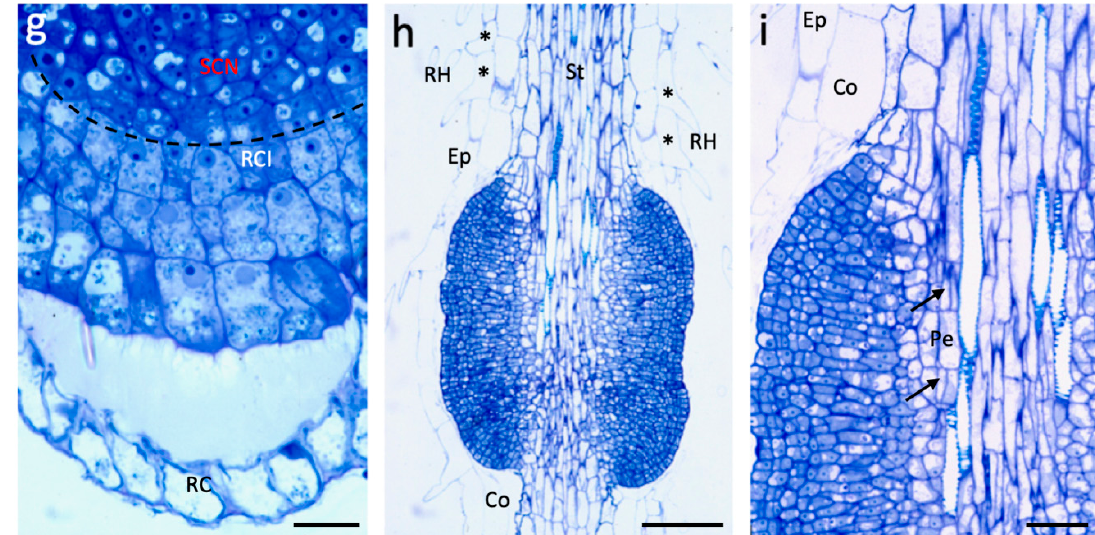
Figure 4. AtAGL12 overexpression in Arabidopsis thaliana . ( a ) Sense (S) T 1 kan R plantlets 10 days after germination; scale bar: 1 cm; ( b ) wild-type (WT) plantlets 10 days after germination; scale bar: 1 cm ( c ) Antisense (AS) T 1 kan R plantlets 10 days after germination; scale bar: 1 cm; for each plantlet, an arrow points to the apical root tip. ( d ) Schematic longitudinal section of a WT Arabidopsis root tip adapted from [28]. The main cell types forming the root apical meristem are indicated in di ff erent colors: RC: root cap (grey-blue); Ep: epidermis (dark blue); Co: cortex (light blue); E: endodermis (purple-grey), Pe: pericycle (purple); St: Stele (orange). In the stem cell niche (SCN, encircled in red) of the meristem, the quiescent center cells (QC, red with asterisks) are surrounded by a small number of initial cells whose descendants will further divide and di ff erentiate. The main areas of the meristem a ff ected by AtAGL12 overexpression are encircled by dashed lines (see 1f and 1g). Scale bar: 20 µ m. ( e ) Longitudinal section of the primary root tip of a S plantlet presenting two fused roots. In S plantlets, the apical root meristematic zone (M) is enlarged and the stele (St) wider. RH: root hair. Scale bar: 100 µ m. ( f ). Longitudinal section of a S plantlet root tip. The meristematic areas principally a ff ected by AtAGL12 overexpression are encircled (dashed lines). Compared to WT (1d), the basal SNC area of the meristem is wider, characterized by a greater number of meristematic cells. Scale bar: 20 µ m. ( g ) Closer view of the 1f root tip focused on the SNC area. Scale bar: 10 µ m; ( h ) longitudinal section of the upper part of the root of a S plantlet showing numerous cell divisions resulting in the formation of abnormal cell masses around the stele. The presence of adjacent trichoblasts (*) developing root hairs (RH) can be observed. Ep: epidermis, Co: cortex, St: stele. Scale bar: 50 µ m. ( i ) Closer view of the cellular protuberance. The arrows point to closely occurring periclinal cell divisions within the pericycle layer (Pe). Further, both anticlinal and periclinal cell divisions explain the important outgrowth of these structures. Scale bar: 20 µ